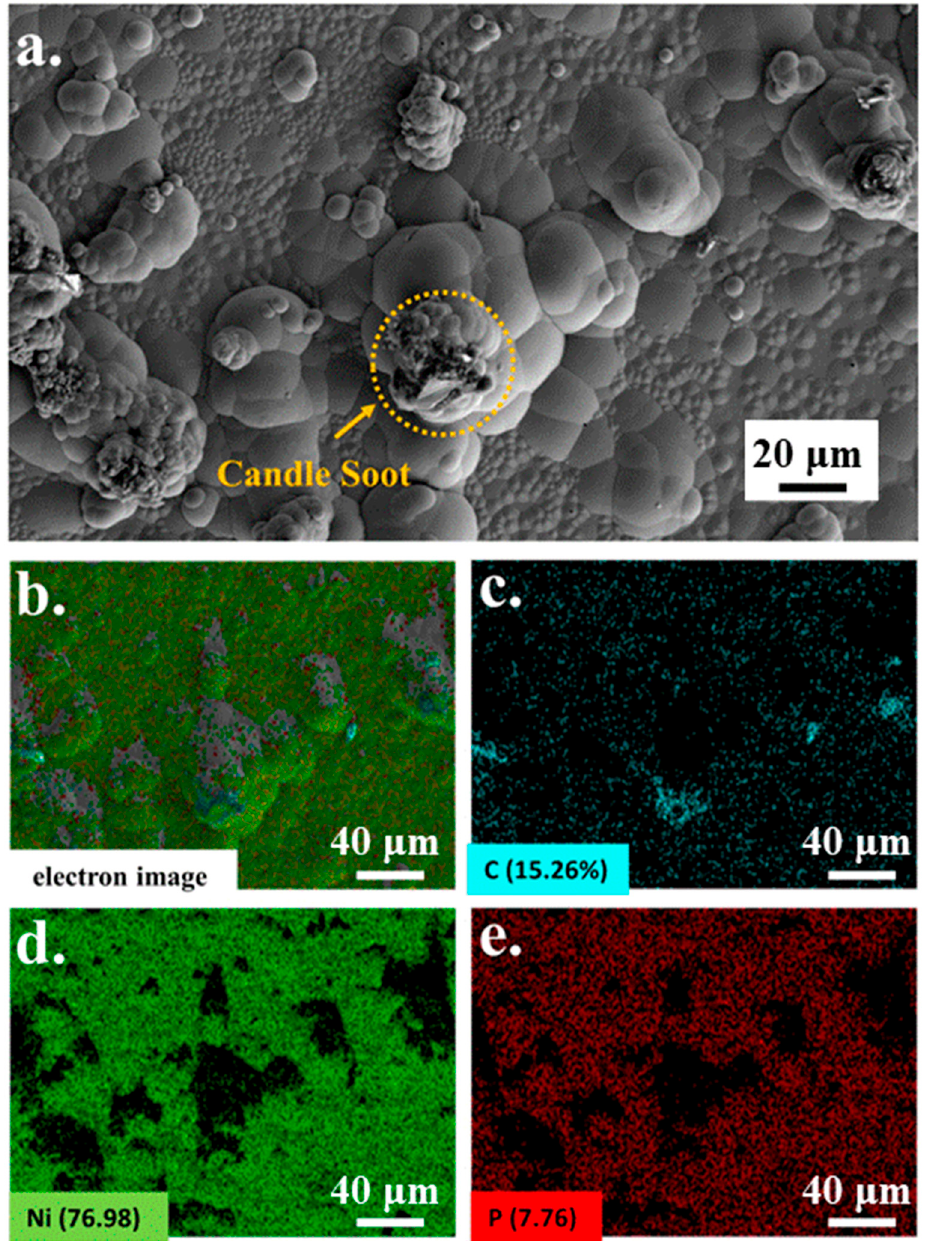
Figure 2. SEM ( a ) of Ni-P-CS and EDS ( b – e ) element content of Ni-P-CS. Physical images of Ni-P coatings and Ni-P-CS composite coatings are presented in Figure 4. There is a clear color difference between the two coatings, with the Ni-P coating showing a yellow metallic luster and the Ni-P-CS composite coating showing a silver metallic luster; both coatings have no apparent cracks or defects on the surface and are relatively